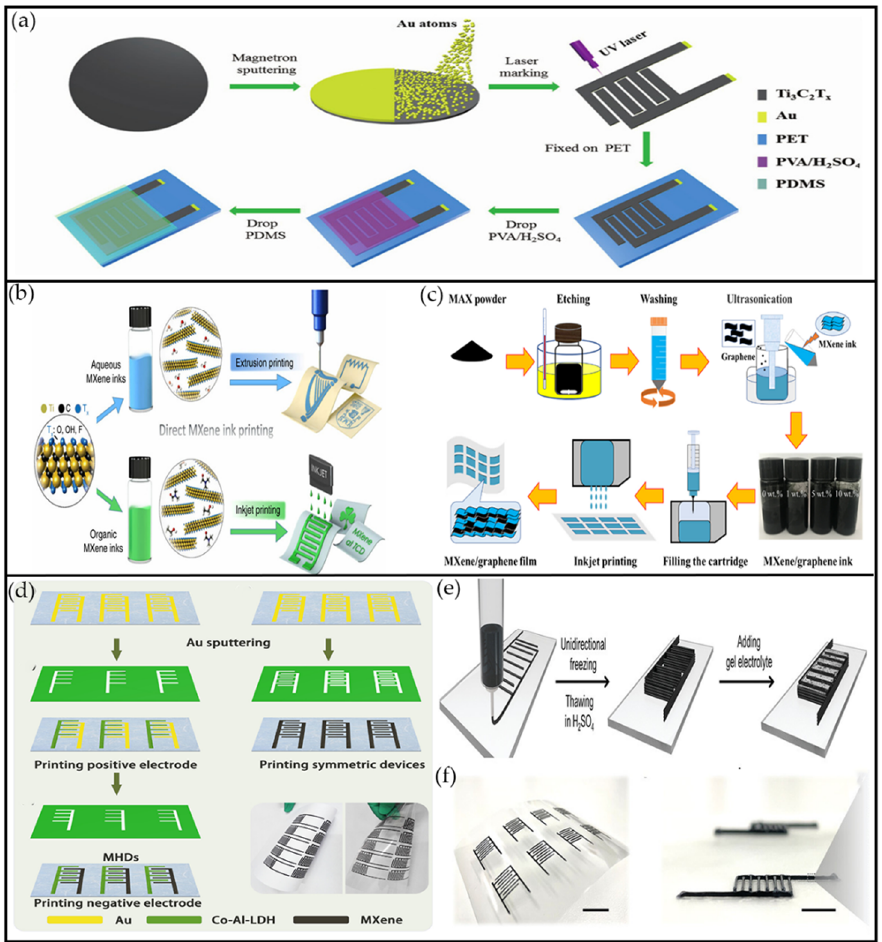
Figure 13. ( a ) Schematic illustration of manufacturing flexible solid-state MSCs. Reprinted with permission from Ref. [170]. Copyright 2018 WILEY-VCH Verlag GmbH & Co., KGaA. ( b ) Schematic illustration of direct MXene ink printing. Reprinted with permission from Ref. [170]. Copyright 2019 Nature Communications . ( c ) Schematic diagram of the inkjet printing of MXene/graphene films. Reprinted with permission from Ref. [171]. Copyright 2022 Journal of Alloys and Compounds . ( d ) Asymmetrical MXene MSCs fabricated by a modified screen-printing process. Reprinted with permission from Ref. [172]. Copyright 2022 Copyright 2018 Nano Energy . ( e ) The fabrication process of 3D printing all-MXene MSC via MSES. ( f ) Photographs of a 3D-printed MXene MSC; scale bar is 1 cm. Reprinted with permission from Ref. [173]. Copyright 2021 Wiley-VCH GmbH.